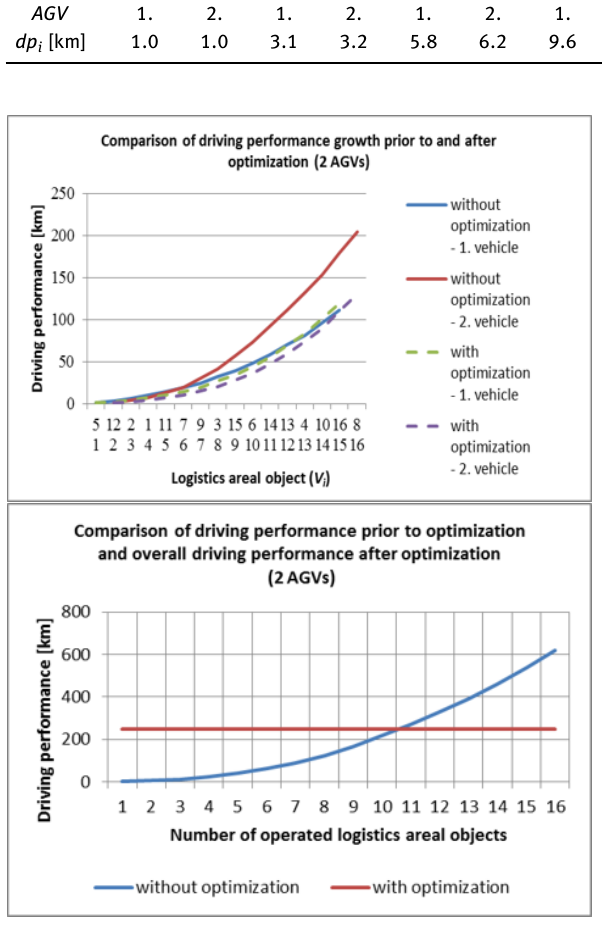
Figure 3: Graphical representation of driving performance prior to and after the distance optimization when using two AGVs From the graph on the right, when using a single AGV, it is clear that the optimized overall driving performance is already achieved after the operation of 14th customer prior to the optimization. In a same way, calculations and graph- ical courses are made in the graphs below (Figure 3 – 6).